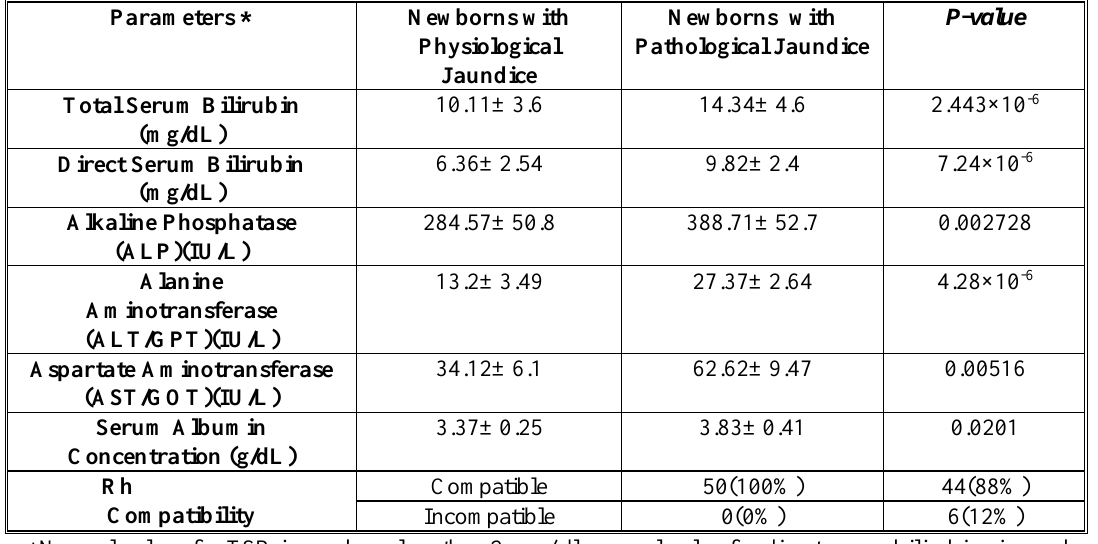
Table 4. Biochemical assay of newborns with physiological jaundice and newborns with pathological